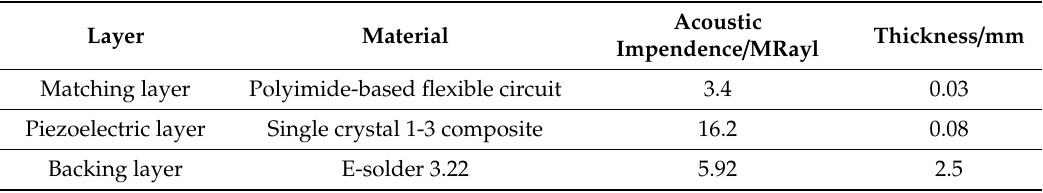
array transducer.